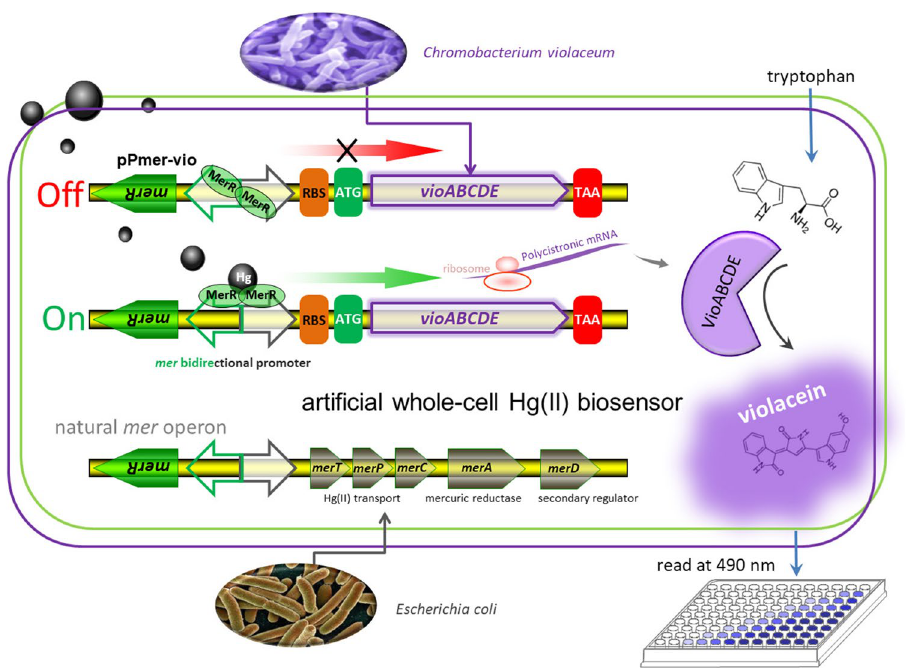
Figure 2. Engineered Hg(II) whole-cell biosensor based on MerR-regulated visual violacein production. The archetype of natural mer operon originated from E. coli is shown at the bottom of the figure. To assemble Hg(II)-responsive visual biosensor, the mercury detoxification gene cluster merTPCAD was substituted with the violacein biosynthetic gene cluster vioABCDE . The violacein biosynthetic module, originated from Chromobacterium violaceum , is transcriptionally regulated by the Hg(II) sensing element to enable a whole-cell violacein-based Hg(II) biosensor. The violacein, produced with bioavailable Hg(II) induction, can be extracted with organic solvents such as butanol, and quantified by a microplate reader at 490 nm.